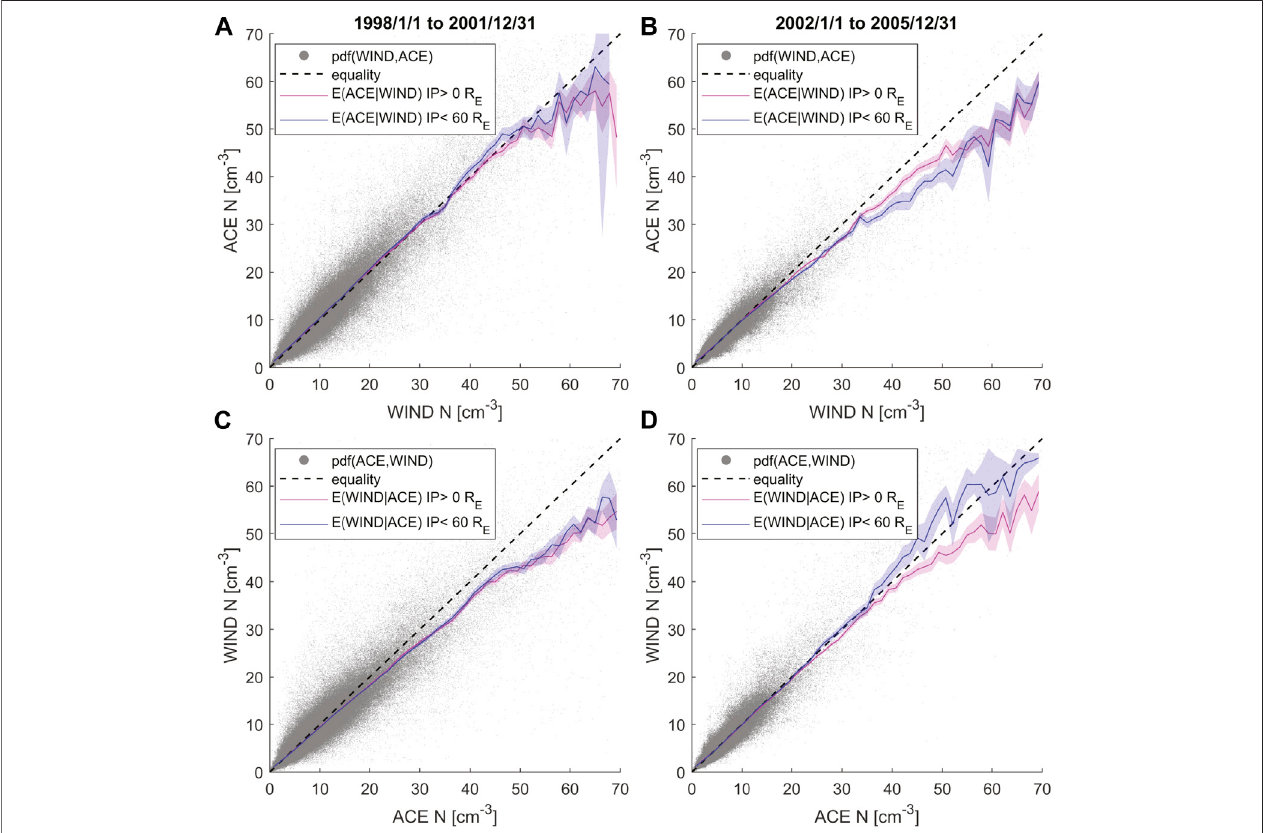
FIGURE 9 | Regression bias in solar wind proton density. It reduces when fi ltering the data to IP < 60 R E and is different for different solar cycle periods. (A) Shows the regression function E ( N ACE | N WIND ) in magenta, and the same restricted to only data with IP < 60 R E in blue. The data spans 1998 to 2001. (B) Shows the same plots butfortheyears2002 – 2005. (C) Showsthereverseregressionof (A) : E ( N WIND | N ACE ),andrevealssimilarbiastowardsthemeanvalue. (D) Showsthereverseregression of (B) . However, when we fi lter the data to only IP < 60 R E , it results in a regression function closer to the line of